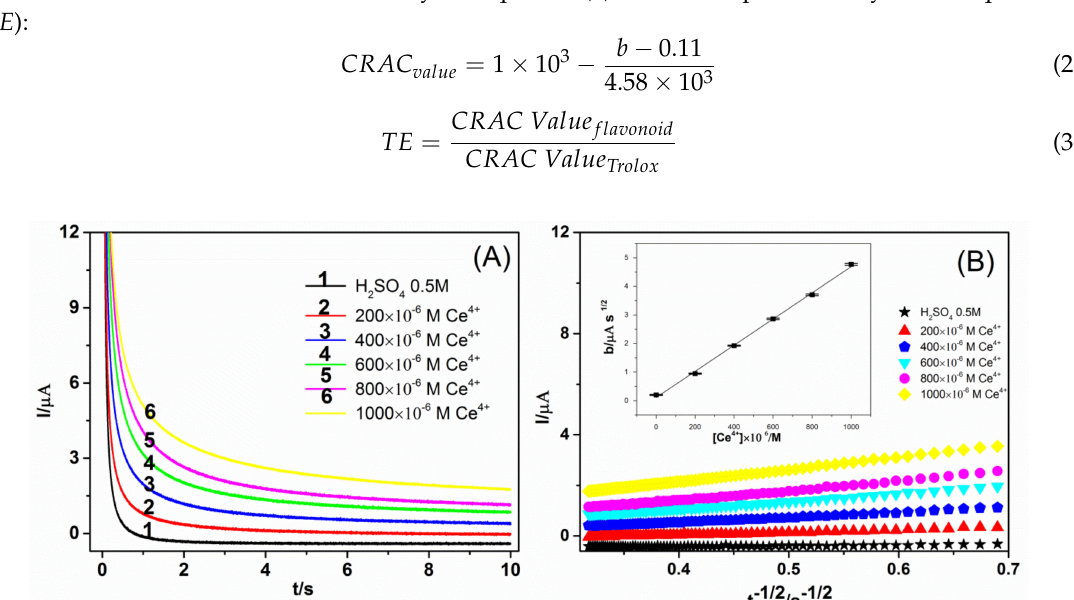
Figure 2. ( A ) Current–time response signal (chronoamperograms) recorded for the supporting electrolyte (H 2 SO 4 0.5 mol L − 1 ) and for Ce 4+ solutions at different concentrations. ( B ) Data plotted as I versus t − 1/2 (Cottrell lines) recorded for the supporting electrolyte (H 2 SO 4 0.5 mol L − 1 ) and for Ce 4+ solutions at different concentrations. Inset with values of the slopes b for the Cottrell lines plotted against Ce 4+ concentrations.